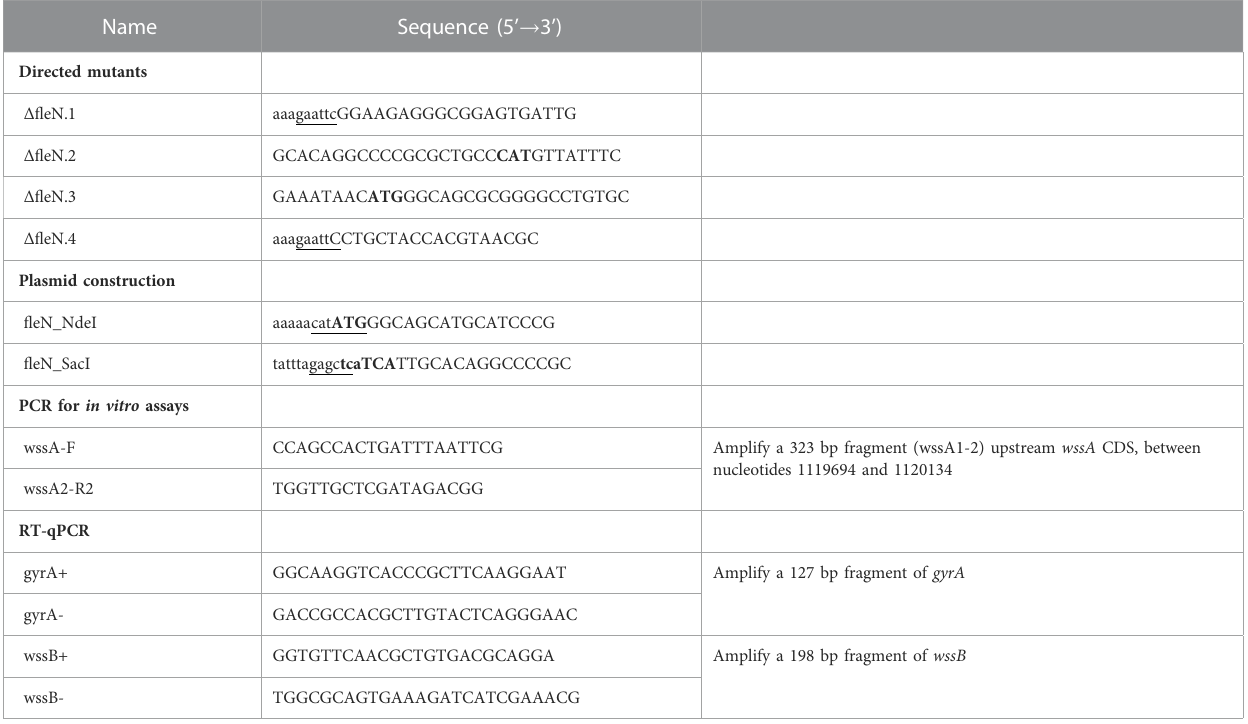
TABLE 2 Oligonucleotides used in this work. Name Sequence (5 ’ → 3 ’